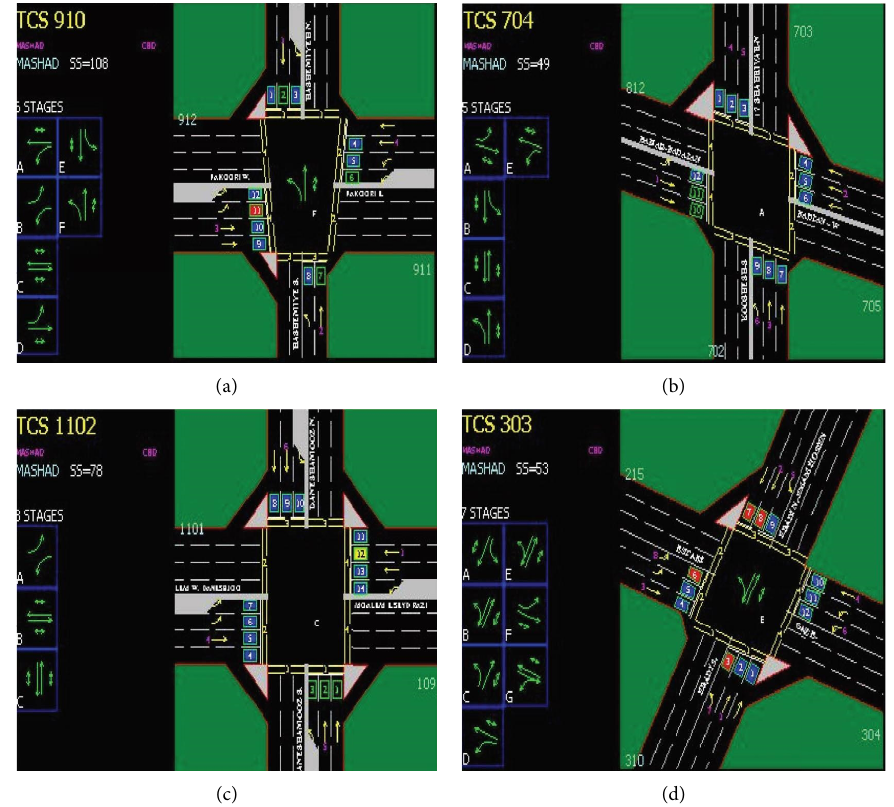
Figure 4: Phase diagrams of the study intersections. (a) Hashemieh-Fakuri. (b) Kooshesh-Fadaiyan. (c) Moallem-Daneshamooz. (d) Gaz-